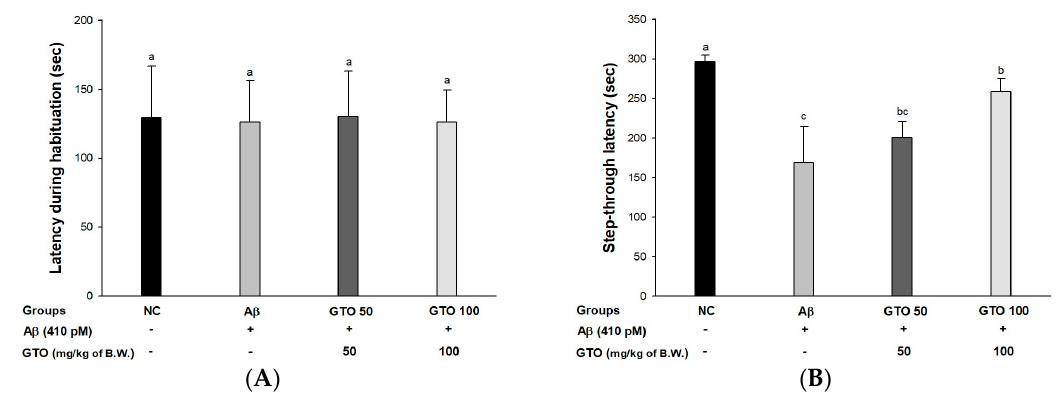
Figure 4. Protective e ff ect of green tea seed oil (GOT) on passive avoidance test in A β -induced mice. ( A ) Latency during habituation; ( B ) step-through latency. Results shown are mean ± SD ( n = 8). Data were statistically represented at p < 0.05, and di ff erent lowercase letters indicate statistical significance. NC: A β − / sample − group; A β : A β + / sample − group; GTO 50: A β + / GTO (50 mg / kg of body weight) + group; GTO 100: A β + / GTO (100 mg / kg of body weight) + group. B.W.: body weight.